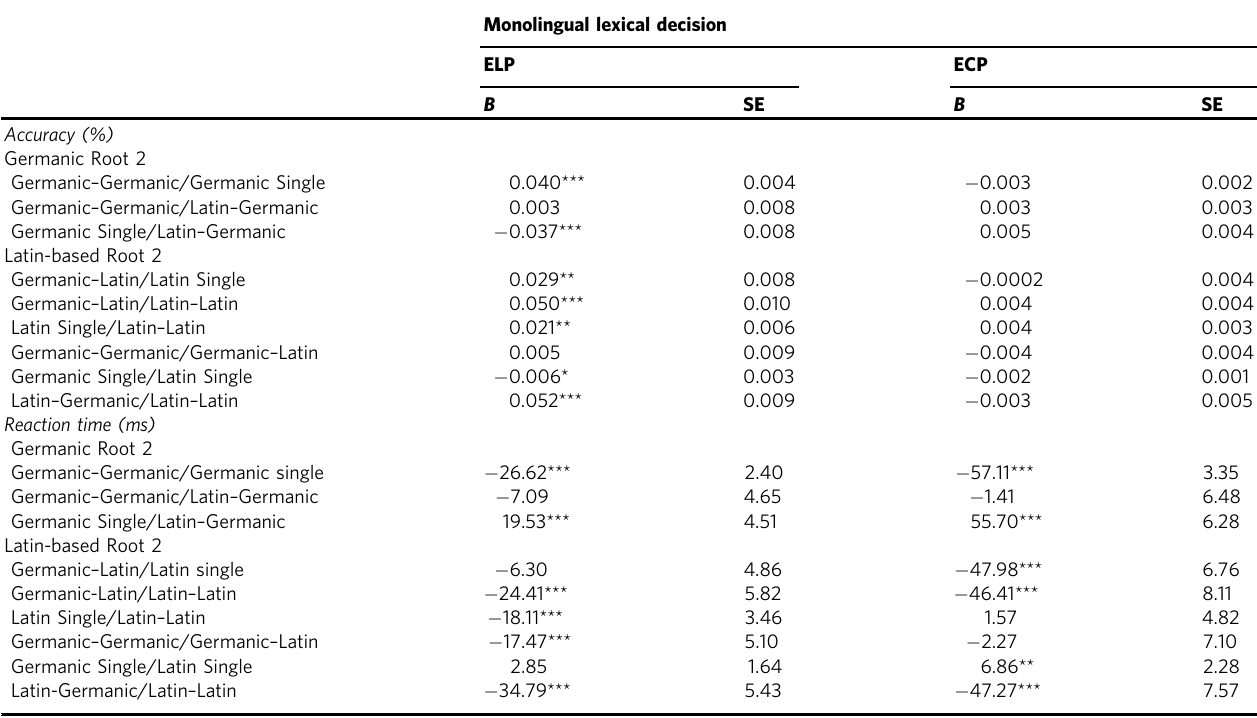
Table 5 English Lexical Project and English Crowdsourcing Project: simple effect/contrast analysis for lexical decision